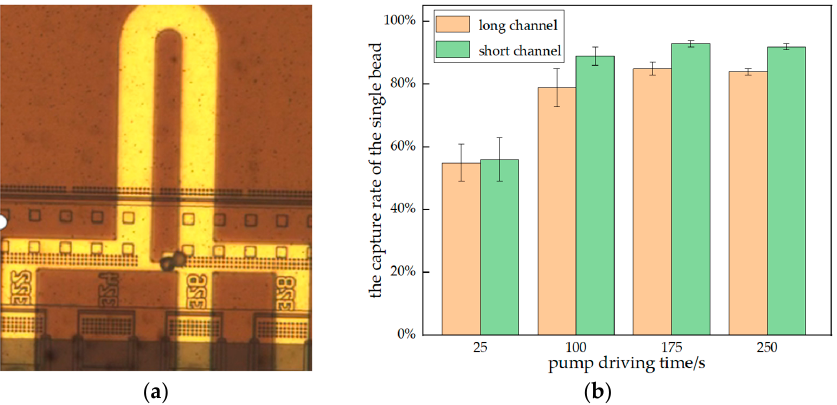
Figure 8. ( a ) A capture channel that trapped two beads; ( b ) the capture rate of the single cell. This shows the e ff ect of the length of the bypass channel on bead multiple capture. Bead multi-capture was signi fi cantly lower with a short channel